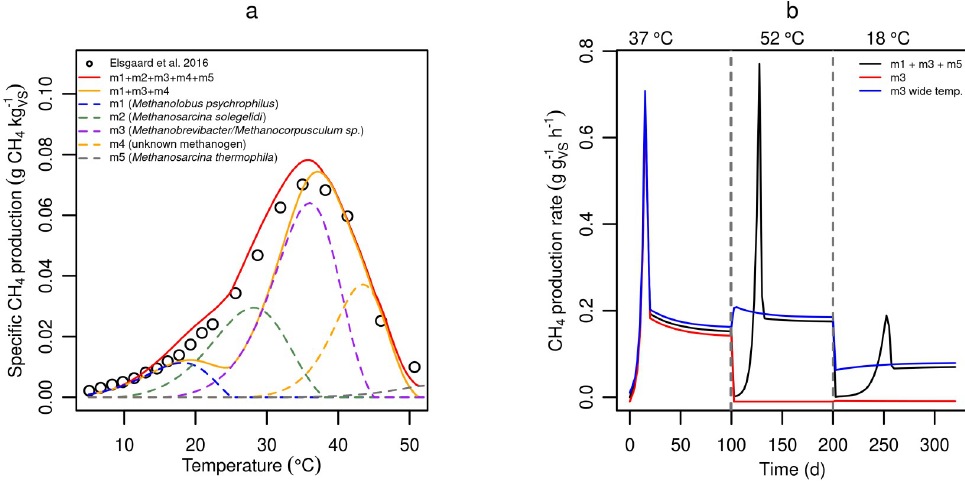
Fig 3. Number of methanogen groups. (a) Predicted CH 4 production of single (dashed colored lines) and multiple (solid lines) methanogen groups as compared to observed CH 4 production in cattle slurry by Elsgaard et al 2016 (circles). (b) Predicted short- and long-term responses to temperature change for different sets of methanogen groups. Note: Lines are shifted up or down by 0.01 for clarity.